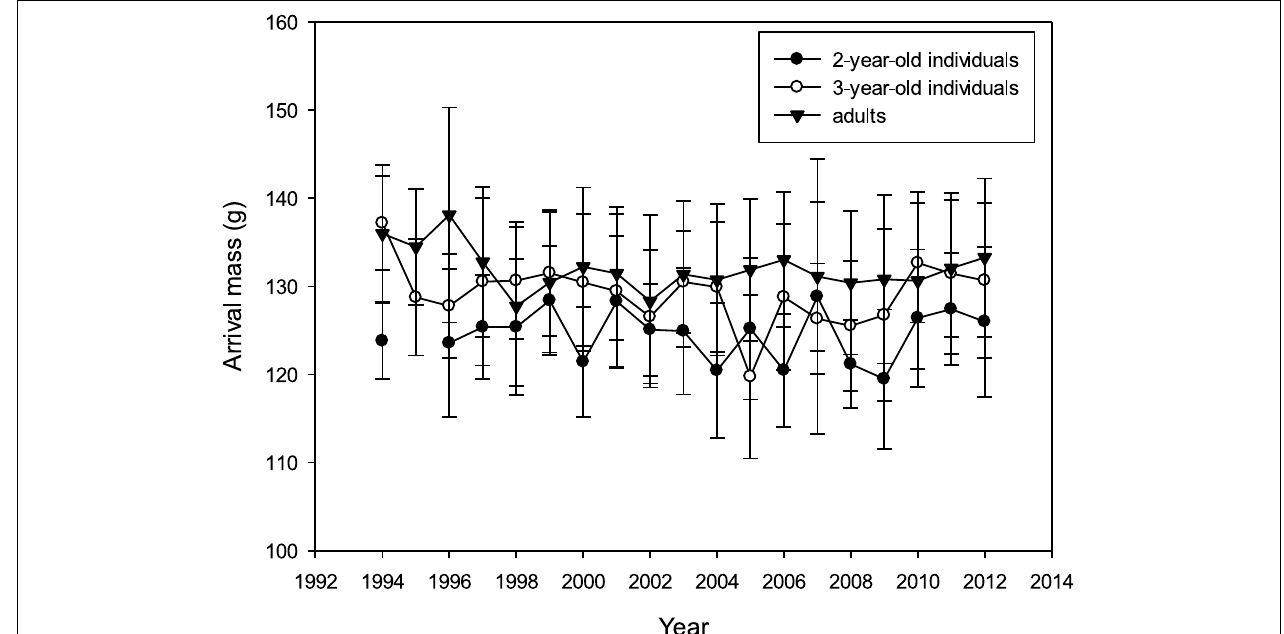
FIGURE 3 | Mass on arrival (mean over first 3 days of colony attendance ± SD; raw data) for 2-year-olds, 3-year-olds and adults between 1994 and 2012 (N 2y = 644 , N 3y = 698 , N ad = 2424